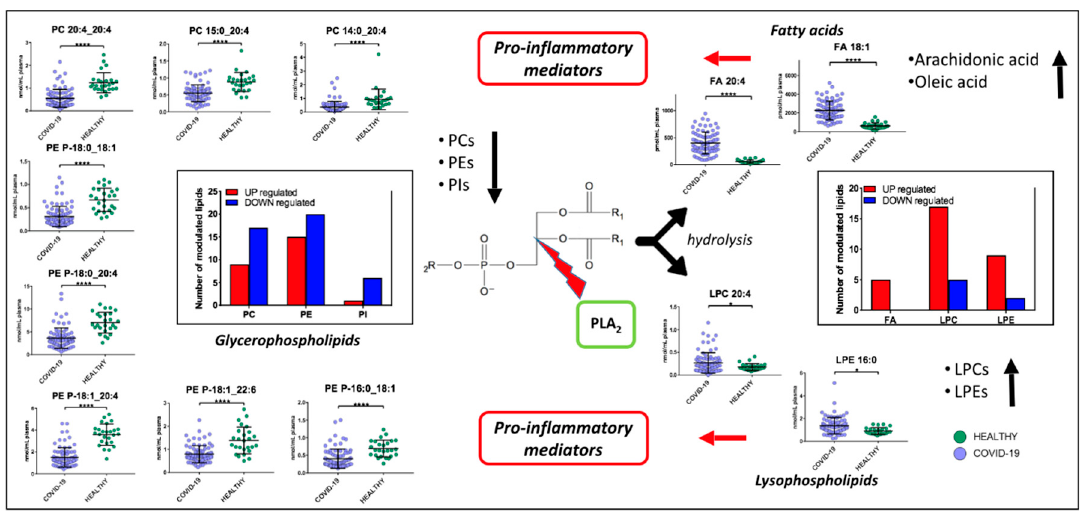
Figure 9. Proposed mechanism involved in COVID-19 pathogenesis. PLA2 hydrolyze phospholipids to yield fatty acids and lysophospholipids. We found a downregulation of glycerophospholipids (PCs, PEs and PIs) and upregulations of lysophospholipids (LPCs and LPEs), arachidonic acid, and oleic acid. Fatty acids and lysophospholipids are pro-inflammatory mediators. ( p -value < 0.05 = *; p -value < 0.0001 = ****).